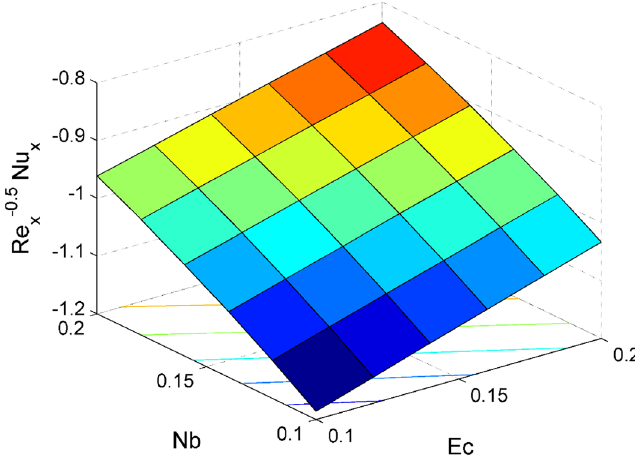
Figure 18. Effect of Nb and Ec on Re − 0.5 x Nu x .